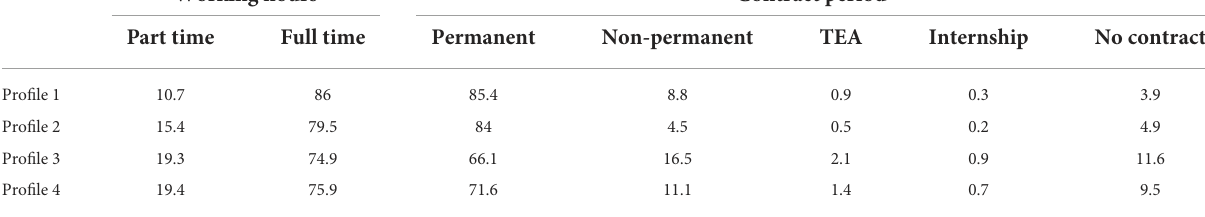
TABLE 4 Working contracts in the different profiles. Working hours Contract period Part time Full time Permanent Non-permanent TEA Internship No